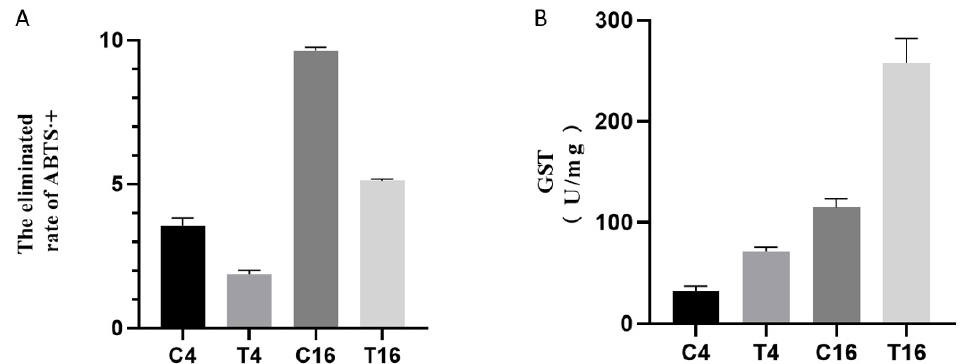
Figure 8. Effect of YB-185 on total antioxidant and glutathione S-transferase (GST) activity of F. pseudograminearum . ( A ) Free radical scavenging activity (ABTS · + elimination rate) of F. pseudograminearum between pure cultures and co-cultures with YB-185; ( B ) GST activity of F. pseudograminearum between pure cultures and co-cultures with YB-185. C4 and T4 samples are crude protein solutions of F. pseudograminearum cultured for 4 h without or with YB-185, respectively, and C16 and T16 samples are crude protein solutions of F. pseudograminearum cultured for 16 h without or with YB-185, respectively.